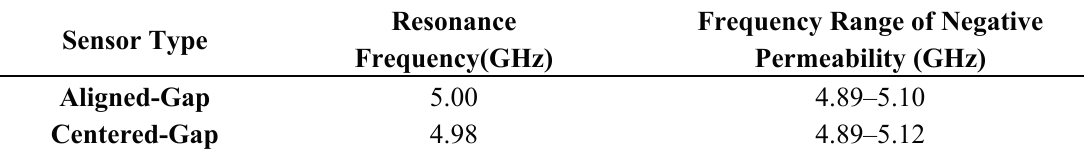
Table 2. Resonance frequency with ranges of the negative permeability for the aligned-gap and centered-gap